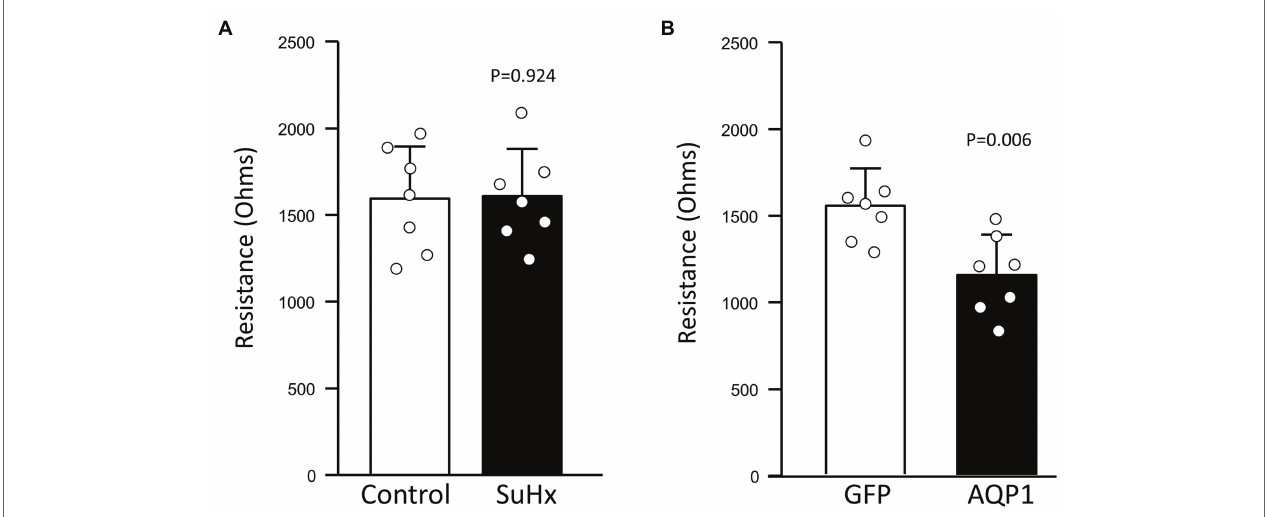
FIGURE 7 | Effect of increasing AQP1 expression on endothelial barrier function. Bar graphs show mean ± SD values for baseline transendothelial resistance measured by electric cell-substrate impedance sensing (ECIS) in MVECs from (A) Control and SuHx rats and (B) from normal rats infected with adenovirus containing GFP (control) or AQP1. Values of p determined by t -test. For all graphs, each dot represents independent experiments with cells from different